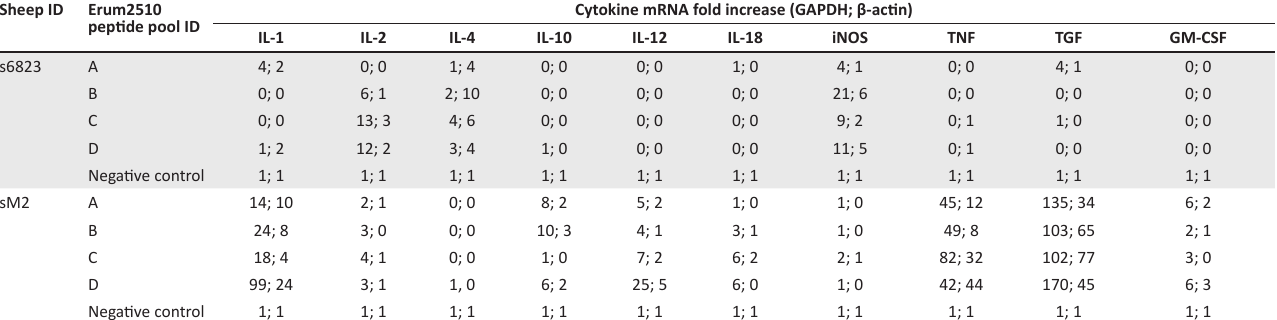
FIGURE 4: Secretion of interferon gamma (IFN- γ ) (a, b) and interleukin 4 (IL-4) (c, d) by immune peripheral blood mononuclear cells (PBMC) from sM2 and s6823 stimulated with Erum2510 r proteins and peptides at a concentration of 10 µg/mL. Only those peptides with positive results are shown with (a, c) r protein 3 and corresponding peptides; (b, d) r protein 4 and corresponding peptides. Unstimulated PBMCs were included as negative control. Data are presented as the average number of spot-forming cells per million. TABLE 2: Relative fold change in cytokine mRNA in peripheral blood mononuclear cells from sM2 and s6823 stimulated with rErum2510 synthetic peptides and normalised to endogenous reference genes glyceraldehyde 3-phosphate dehydrogenase (GAPDH) and β-actin, relative to an untreated negative control (unstimulated peripheral blood mononuclear